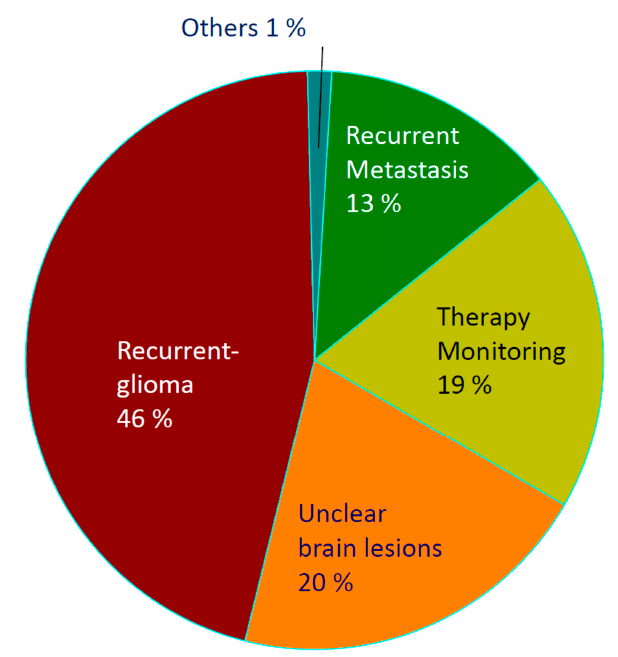
Figure 1. Number of FET PET investigations at the FZJ since 2001. Figure 2. Fraction of indications in